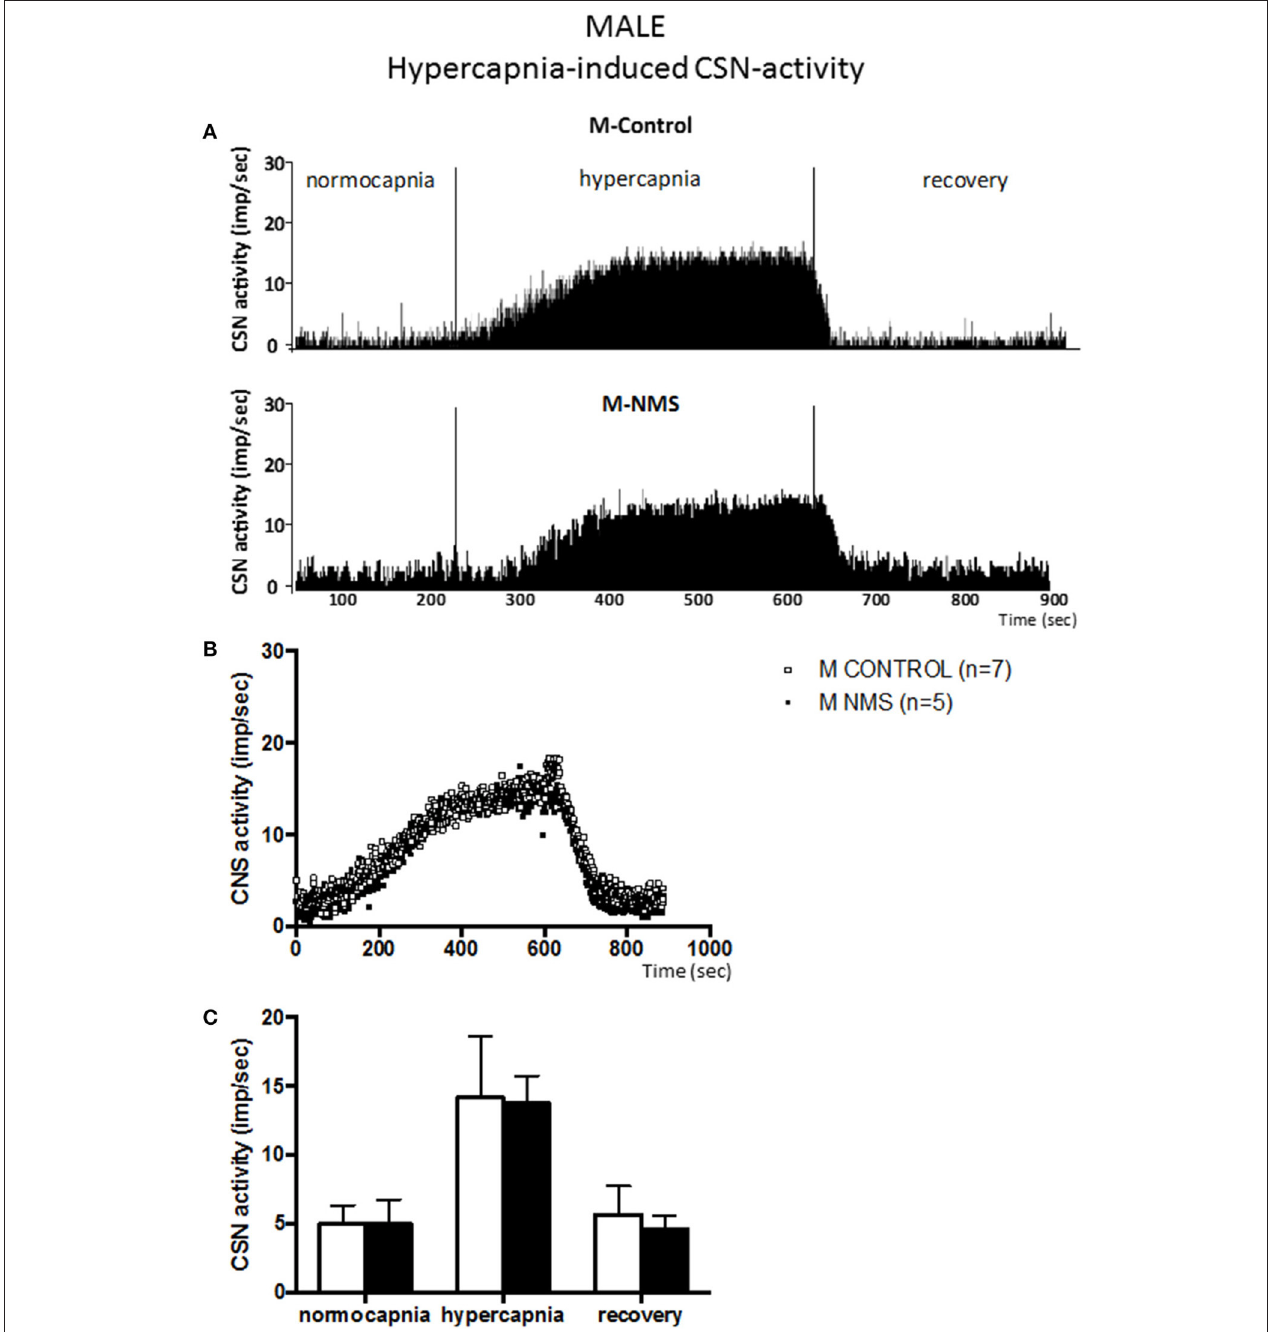
FIGURE 3 | Neonatal maternal separation (NMS) does not alter the hypercapnic carotid sinus nerve (CSN) response to hypercapnia in male rats. (A) Original recordings comparing CSN activity from ex vivo preparations of perfused carotid body/CSN from control and NMS males under hyperoxia (FiO 2 = 0.95), hypercapnia (FiCO 2 = 0.30) and hyperoxia after hypercapnia (recovery). (B) Comparison of the mean carotid sinus nerve activity (imp/sec) over the course of the hypercapnic protocol between carotid bodies from control (open squares; n = 7) and NMS rats (black squares; n = 7). Hypercapnia begins at T = 0 and is maintained until T = 500s (end of plateau phase), followed by hyperoxic recovery; each data point represents the mean value on a second by second basis. (C) Histograms comparing mean CSN activity for each specific experimental condition between control (white bars; n = 7) and NMS (black bars; n = 7) male rats. Data are reported as means ± SD